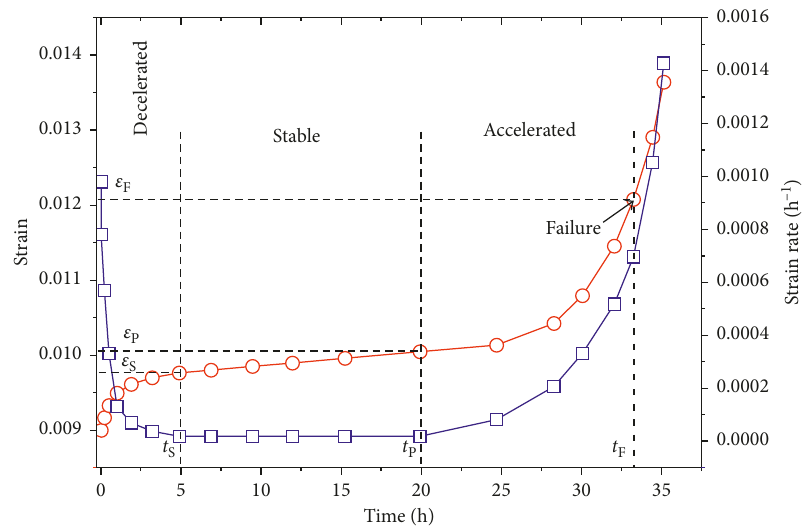
Figure 5: Strain of mudstone and strain rate over time (under saturated